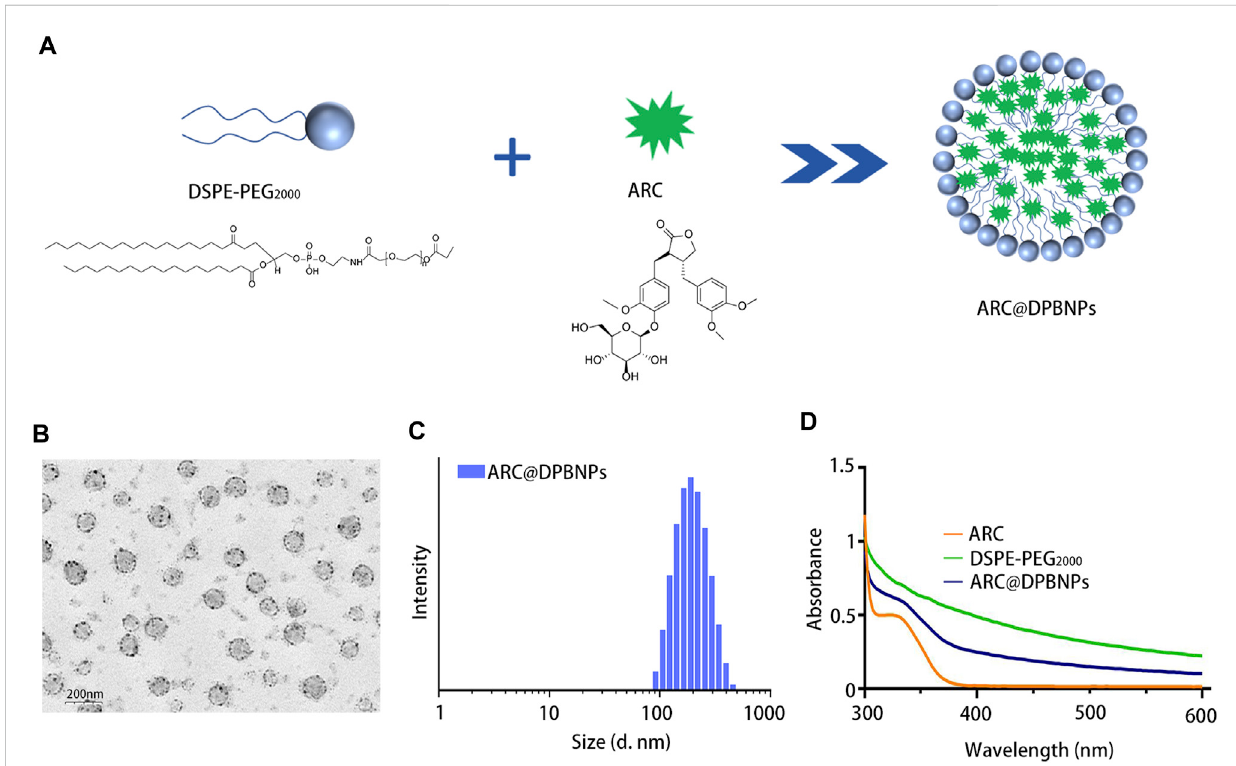
FIGURE 2 Arctiin (ARC)-encapsulated DSPE-PEG bubble-like nanoparticle (ARC@DPBNP) construction and characterization. (A) Chemical structures of DSPE-PEG2000 and ARC, and a schematic diagram showing ARC@DPBNP preparation. (B) Typical transmission electron microscopy (TEM) images of ARC@DPBNPs, scale bar = 200 nm. (C) Size distribution of ARC@DPBNPs according to a Nano ZS zetasizer. (D) Ultraviolet-visible absorption spectra of ARC, DPBNP, and ARC@DPBNP